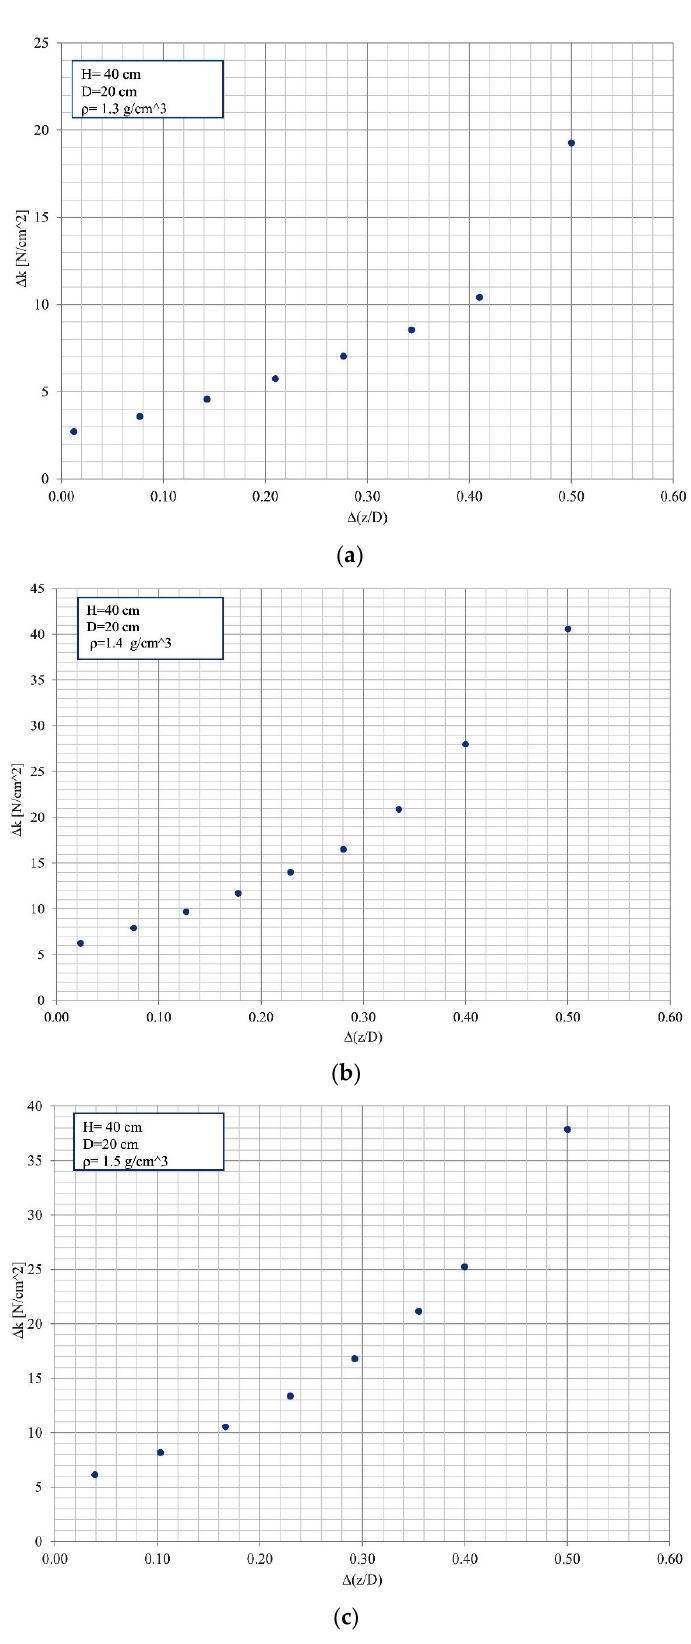
Figure 11. The relationship of ∆k and ∆(z/D) for a soil thickness level of 40 cm at bulk densities of ( a ) 1.3 g/cm 3 , ( b ) 1.4 g/cm 3 , and ( c ) 1.5 g/cm 3 .